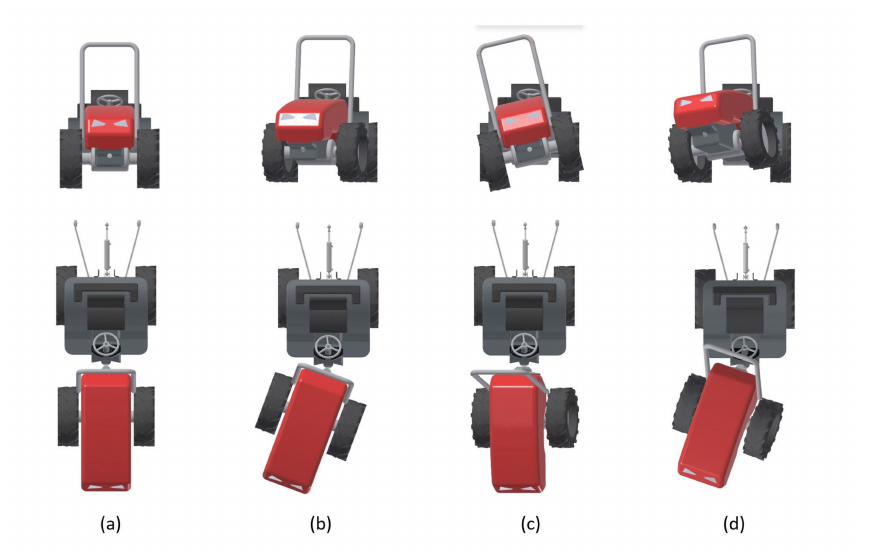
Figure 4. The configurations of the compact articulated chassis tractor: ( a ) Straight; ( b ) Yaw angle; ( c ) Roll angle; ( d ) Yaw and Roll